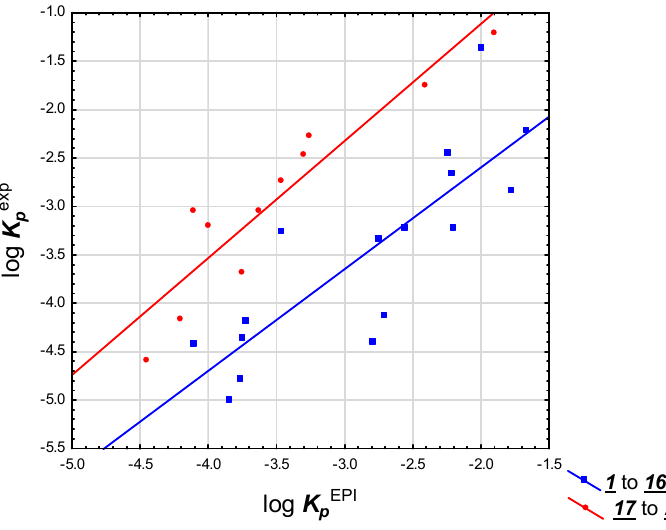
Figure 2. log K p experimental values vs. EpiSuite, compounds 1 to 27 .